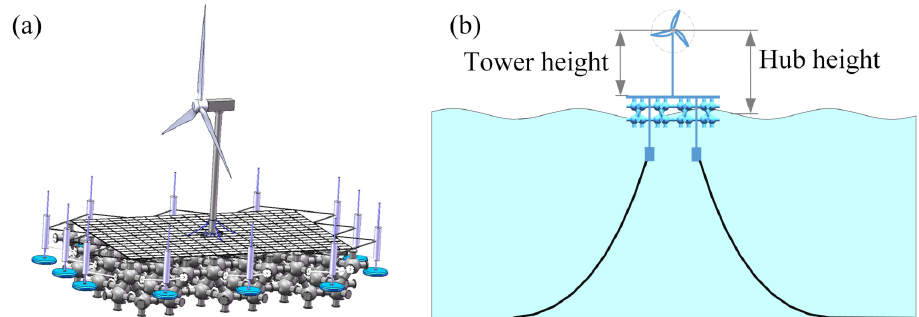
Figure 4. ( a ) Concept of the hybrid floating system; ( b ) simplified floating system.